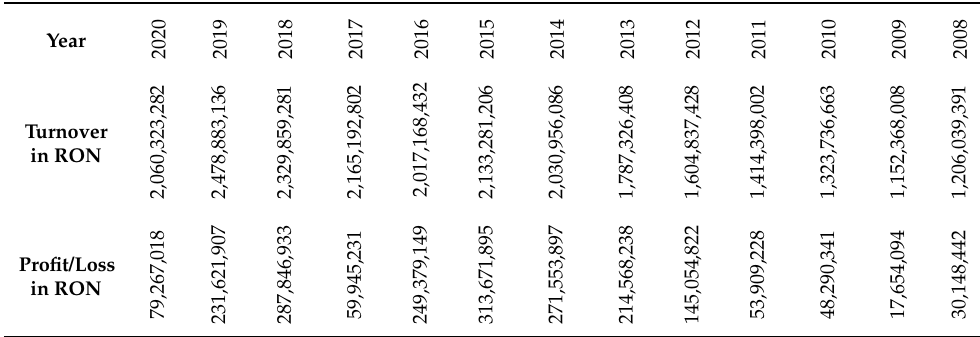
Table 5. Statistical data used for this model.